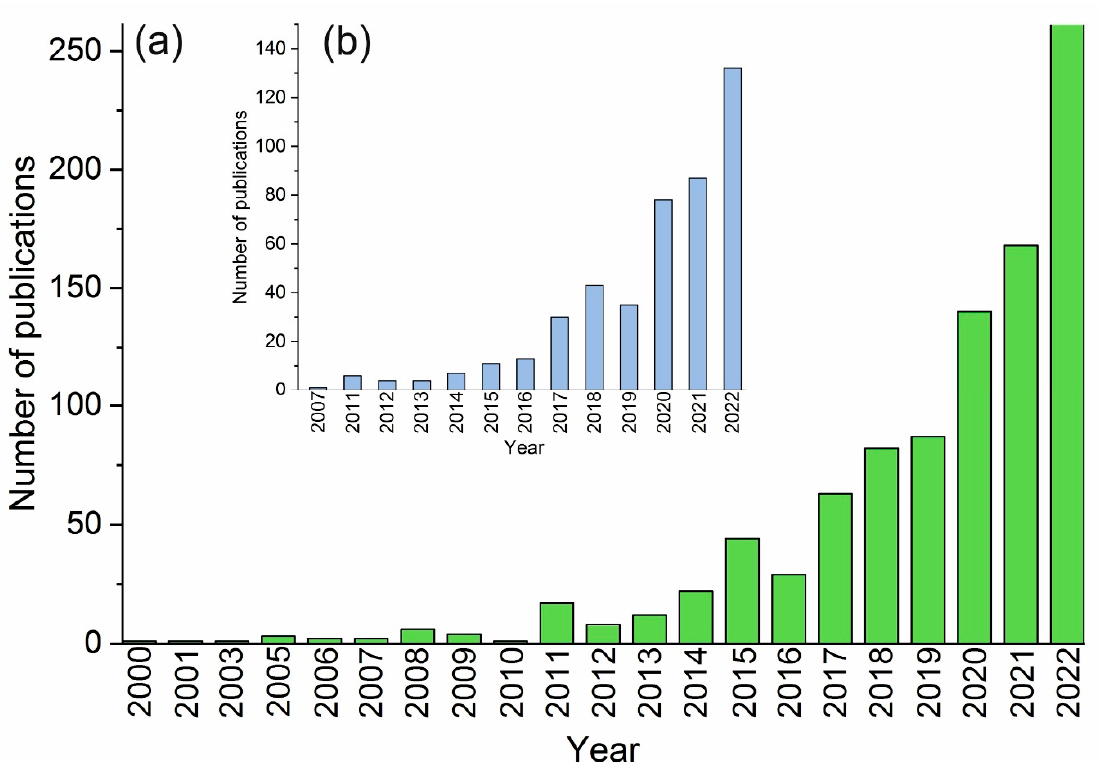
Figure 1. The number of articles on oleogelation topic per year; ( a ) Scopus database search using the keyword “oleogels”; ( a , b ) Scopus database search using the keyword “oleogels” and “food”; (actualization date 18 October 2022).